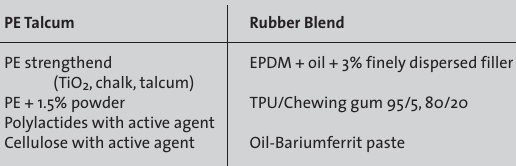
Table 5: Typical compounding applications as tested on the